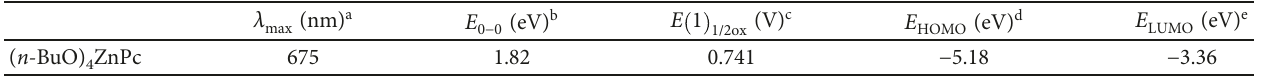
Figure 1: (a) Black solid line: normalized ( n -BuO) ZnPc UV-Vis absorption in acetonitrile. Black dashed line: emission spectrum in 4 acetonitrile. Red solid line: Q-band absorption spectrum of a spin-coated fi lm on nonconductive glass. (b) Red solid line: ( n -BuO) ZnPc 4 fl uorescence decay in acetonitrile. Black solid line: prompt. Table 1: Optical and electrochemical properties of ( n -BuO) 4